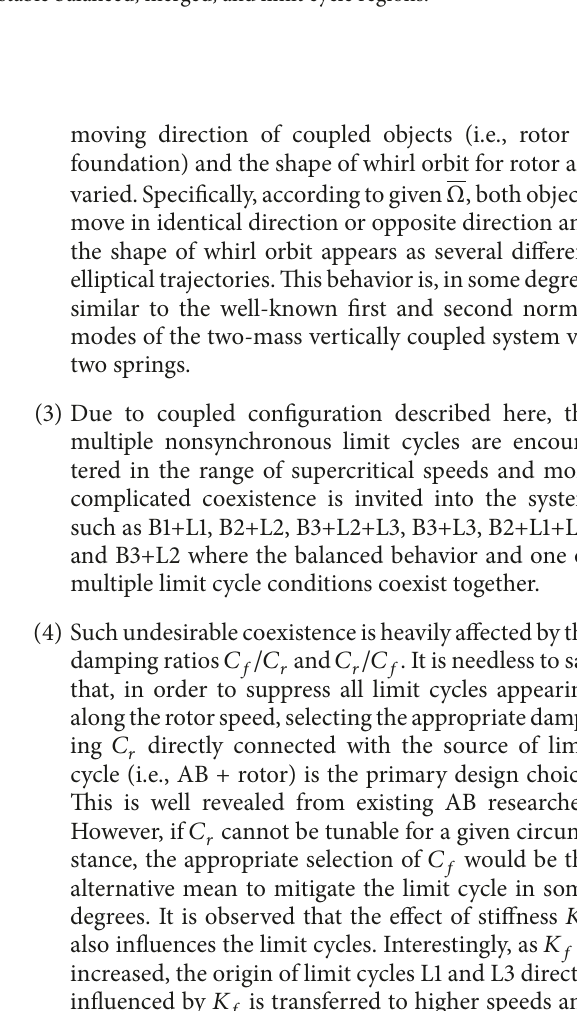
Figure 11: Effect of stiffness 𝐾 𝑓 and rotor speed Ω on stable balanced, merged, and limit cycle